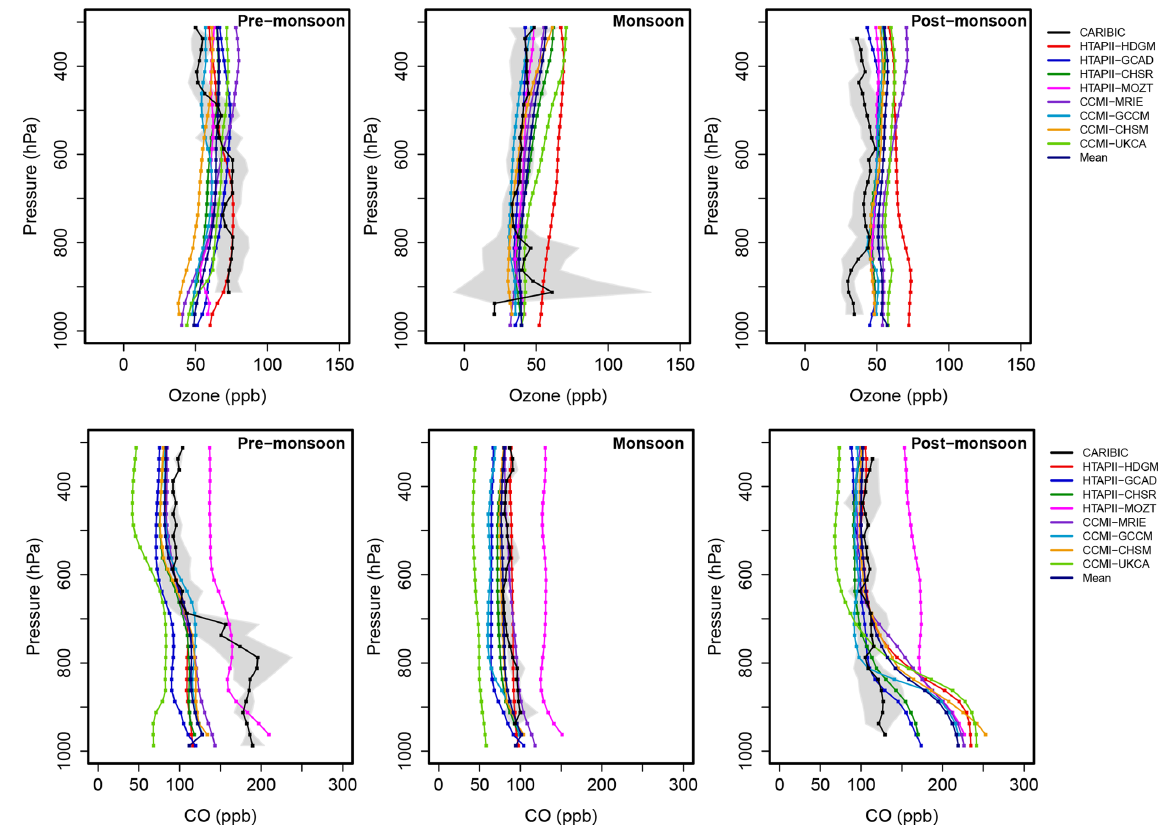
Figure 13. Comparison of ozone and carbon monoxide profiles from model simulations, 2009–2010, with the CARIBIC observations in Chennai for pre-monsoon (April–May), monsoon (June–September) and post-monsoon (October–December) seasons, 2008. Model simula- tions have been vertically interpolated along the CARIBIC flight pressure levels. The mean of the data collected during the aircraft descent and ascent is shown